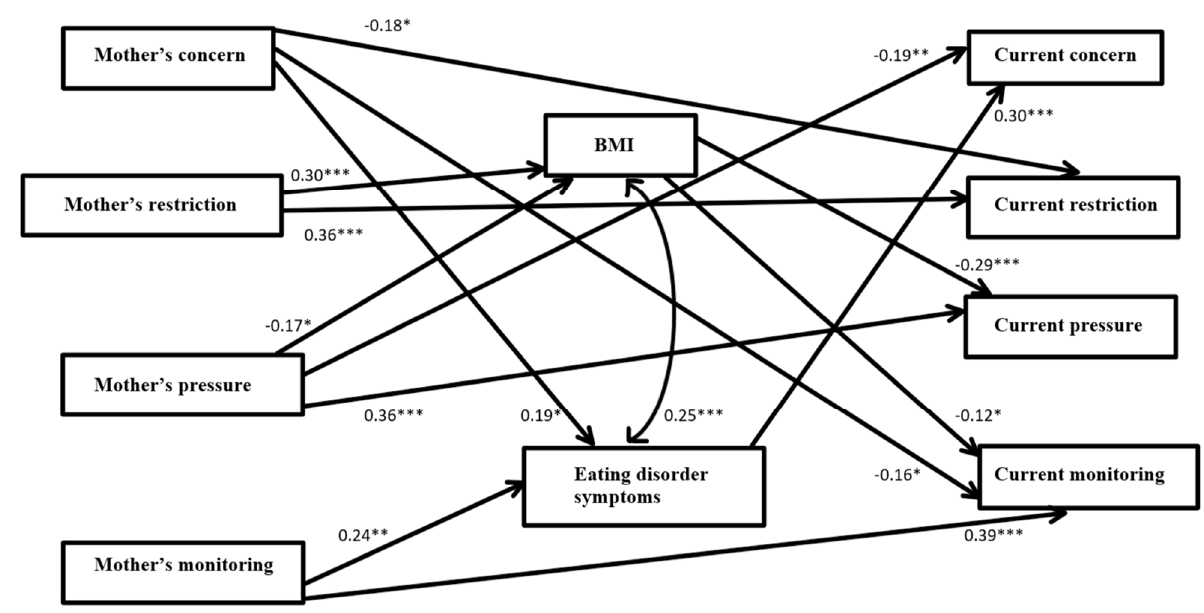
Figure 1. Path analysis: disordered eating and BMI as mediators between retrospectively recalled maternal CFQ and current CFQ. Note: Mother’s CFP relate to what the participant reported concerning their mother’s CFP when they were children. * p < 0.05; ** p < 0.01; *** p < 0.001; current CFP relates to the way participants feed their own children. Concern = concern for child’s weight; Restriction = restriction of food intake; Pressure = pressure to eat; Monitoring = monitoring child’s food intake.